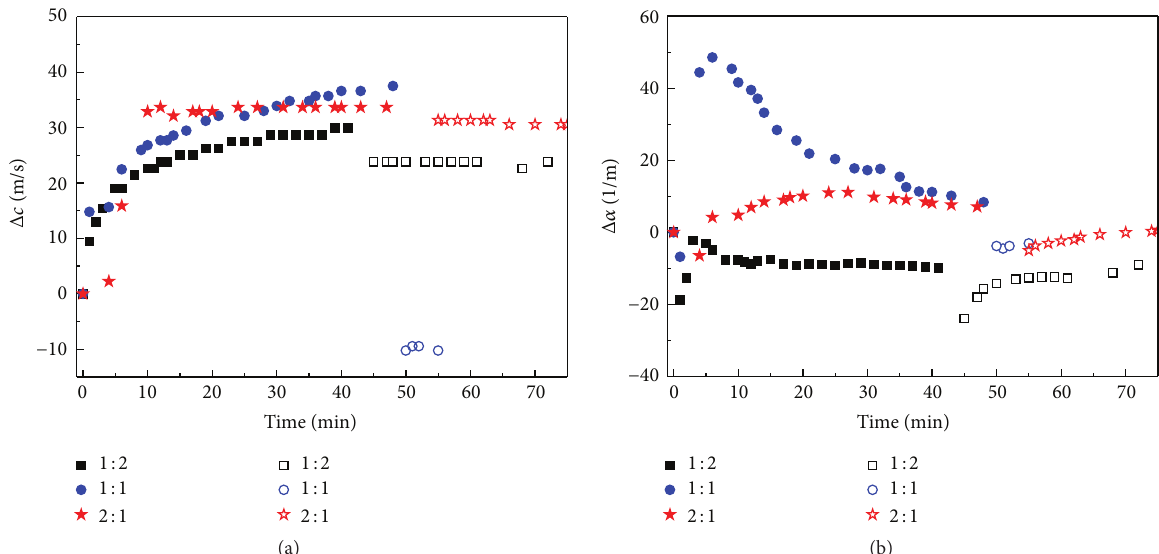
Figure 10: The changes of ultrasonic wave velocity (a) and attenuation (b) as a function of time after the application of a magnetic field. Open symbols represent values after the removal of the magnets.